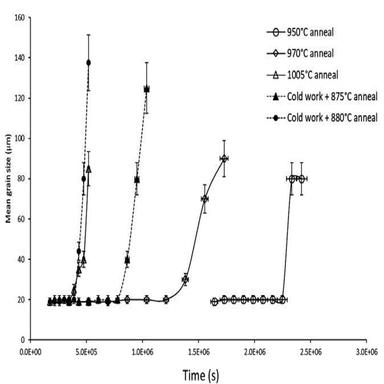
Average grain size d¯ ss (mm) vs annealing time (s) for various treatment con-